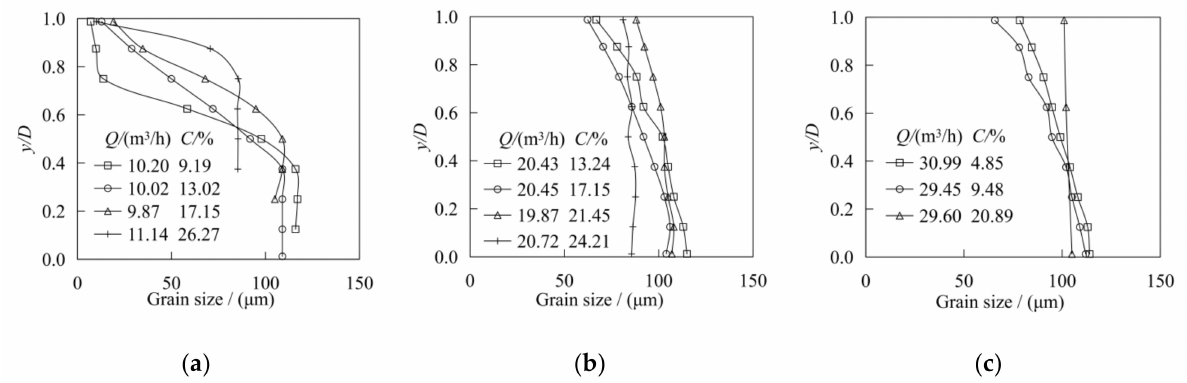
Figure 14. Distribution of the median particle size (d 50 ) along the vertical direction at different sediment concentrations and different discharges: ( a ) Q = 9.87–11.14 m 3 /h; ( b ) Q = 19.87–20.72 m 3 /h; and ( c ) Q = 29.45–30.99 m 3